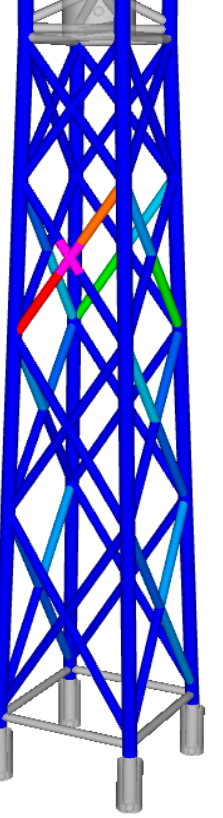
Figure 12. Location of the worst-performing joint.